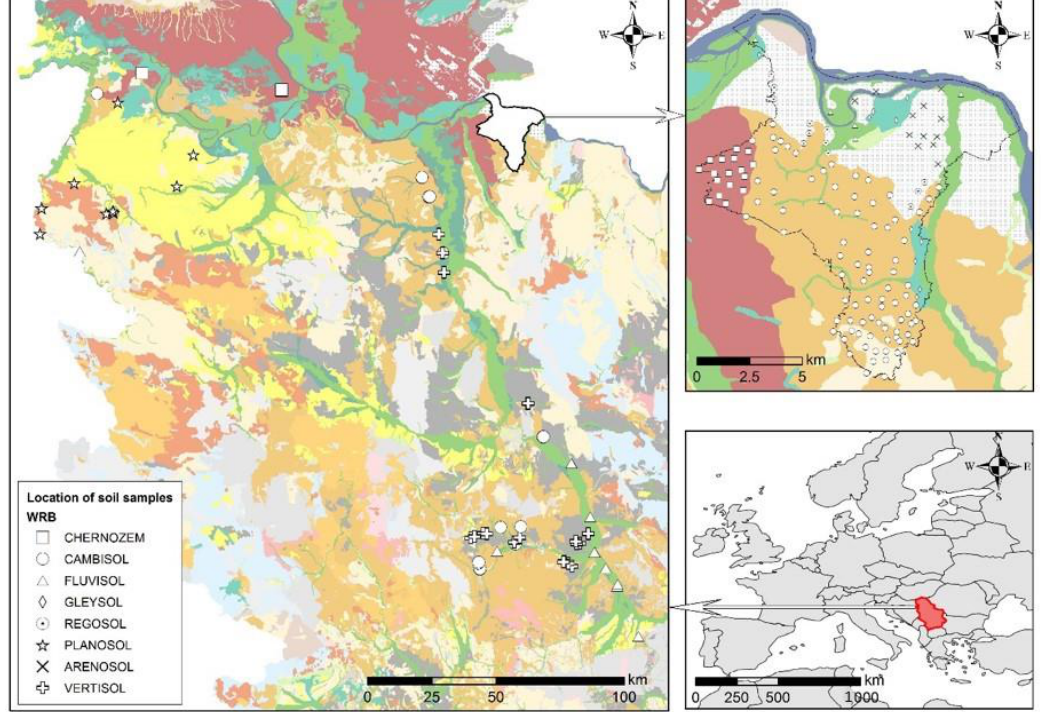
Figure 1. Soil sampling locations with soil type in the Republic of